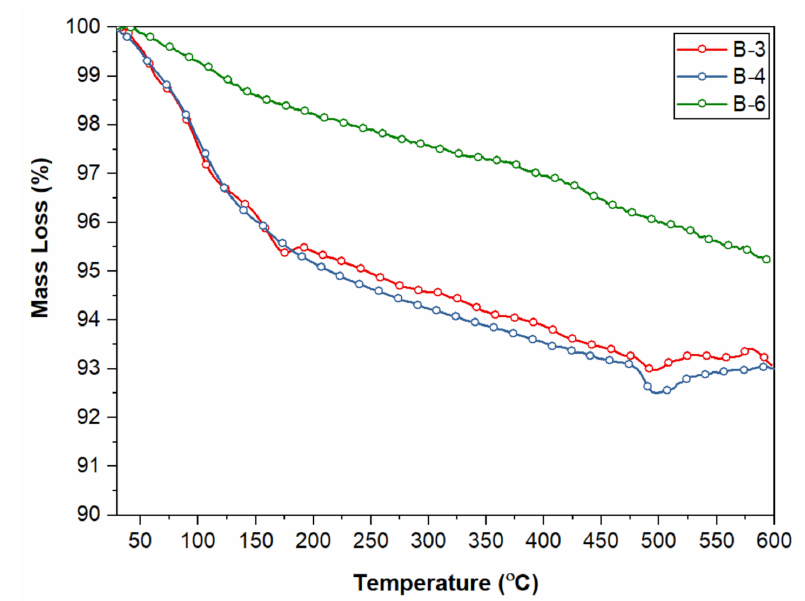
Figure 8. TGA analysis of waste mask-filled